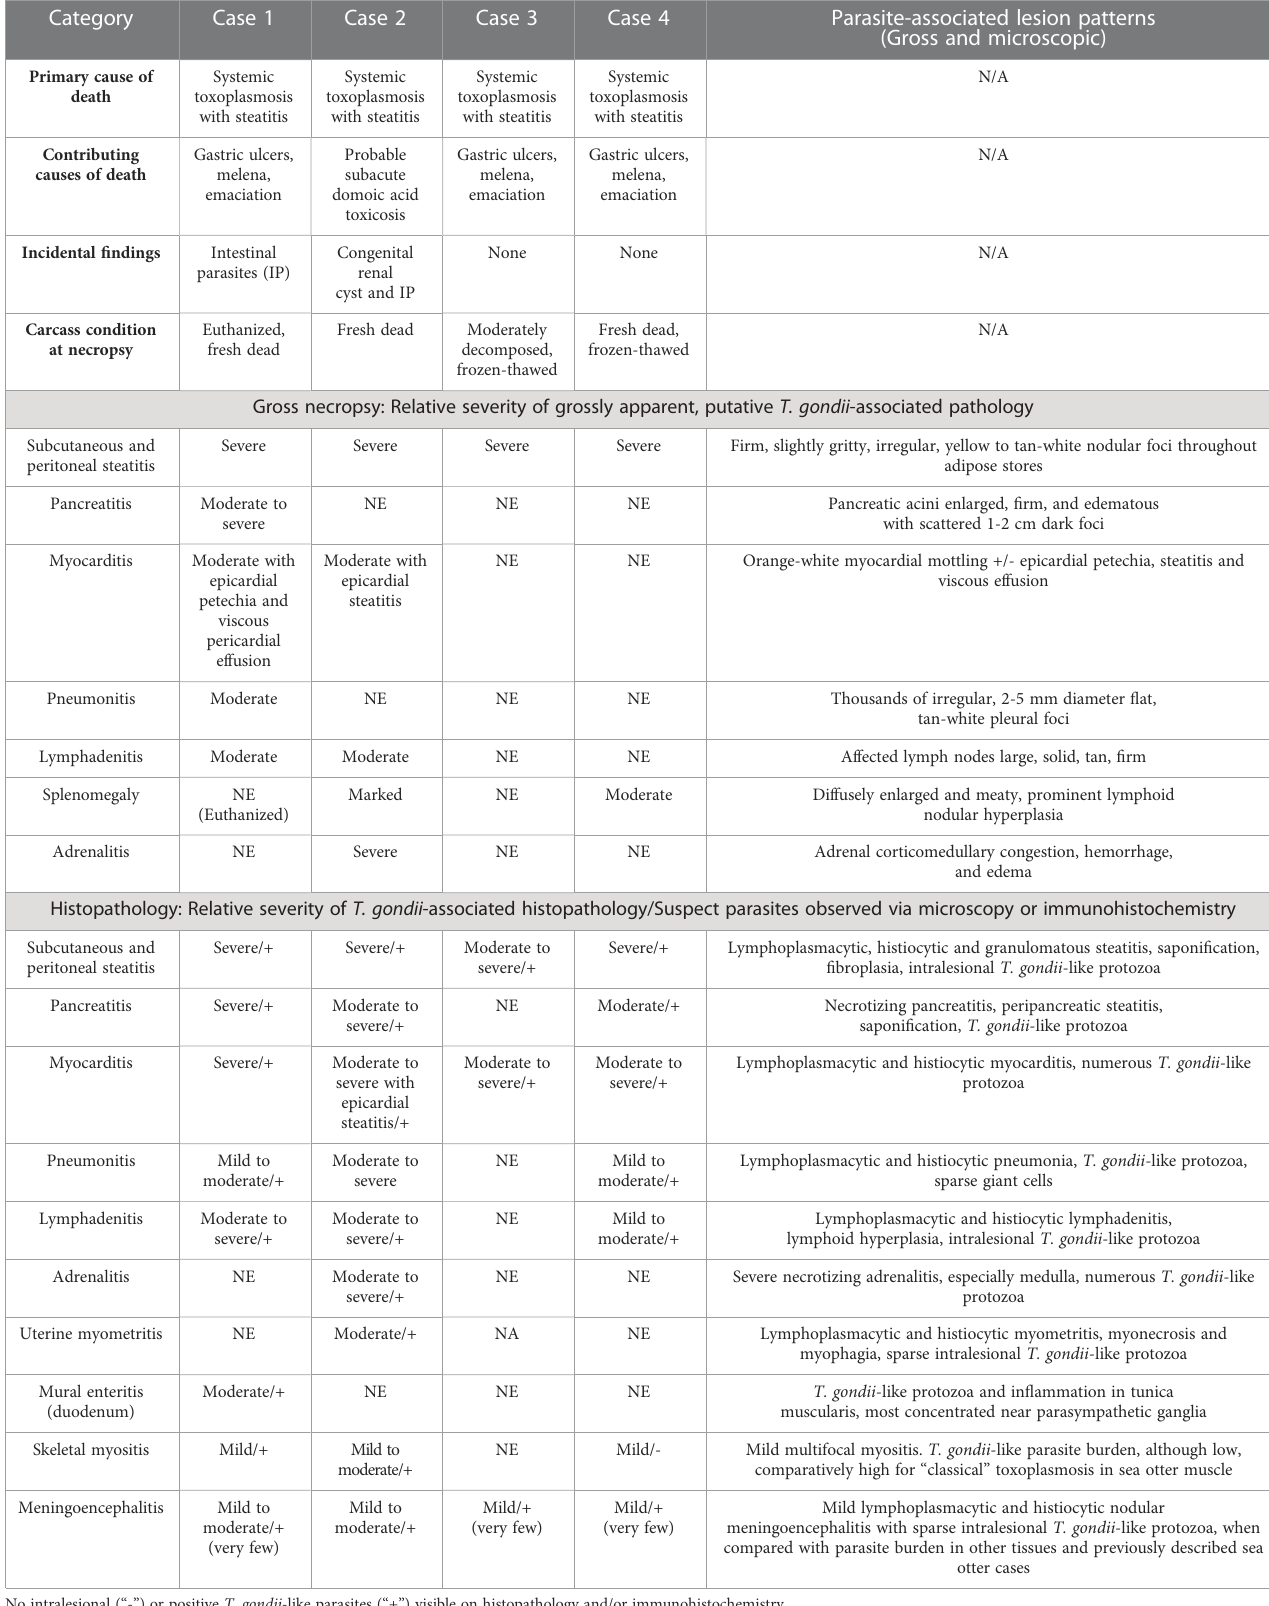
TABLE 2 Toxoplasma gondii -associated gross and microscopic pathology for southern sea otters ( Enhydra lutris nereis ) with fatal T. gondii -associated steatitis and toxoplasmosis.